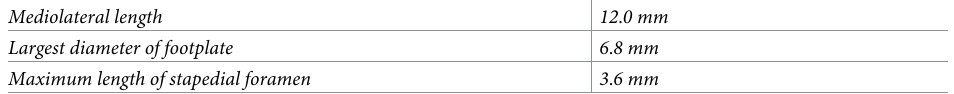
Table 2. Measurements of the stapes in MB.R.999.